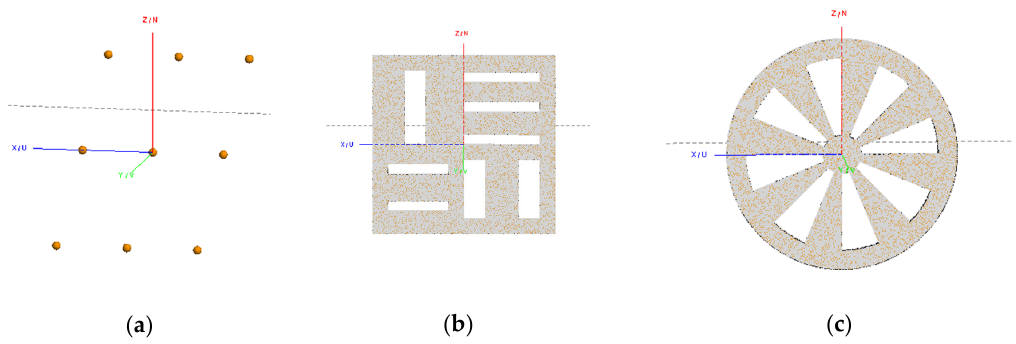
Figure 7. ( a ) CAD model of nine identical spheres by FEKO; ( b ) CAD model of a slab square after meshing by FEKO; ( c ) CAD model of a Siemens Star after meshing by FEKO.